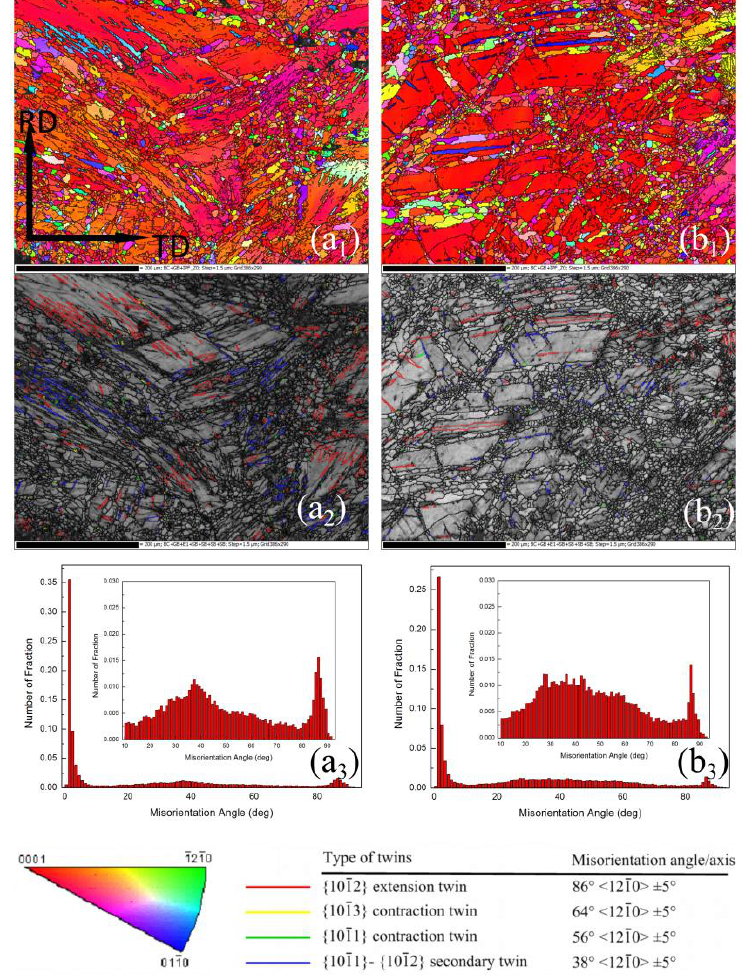
Figure 5. Electron back-scatter diffraction (EBSD) results of AZ31 alloys HSRBFed to different accumulated strains ( a ) 0.22, ( b ) 0.44, including inverse pole figure maps ( a 1 , b 1 ), boundary misorientation maps ( a 2 , b 2 ) and misorientation angle distributions ( a 3 , b 3 ).